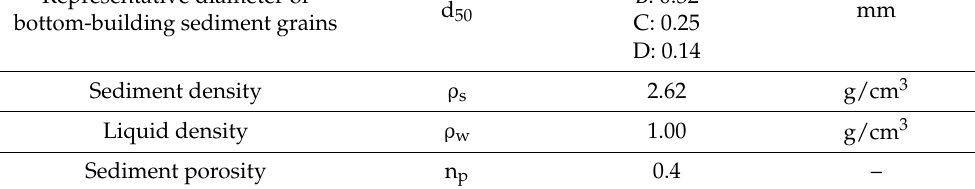
Table 1. Basic data of the flat bottom experiment—IBW PAN 2020. Parameter Symbol Value Unit Water depth h 0 0.28/0.36 Wave height H w Test duration Wave peak period Representative diameter of bottom-building sediment grains